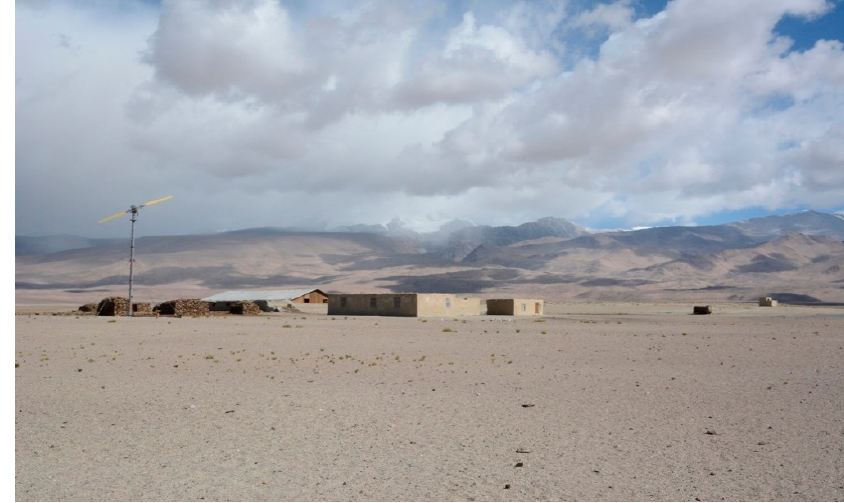
Figure 4. An isolated kyshtoo (Photograph: S.S., September 2015).